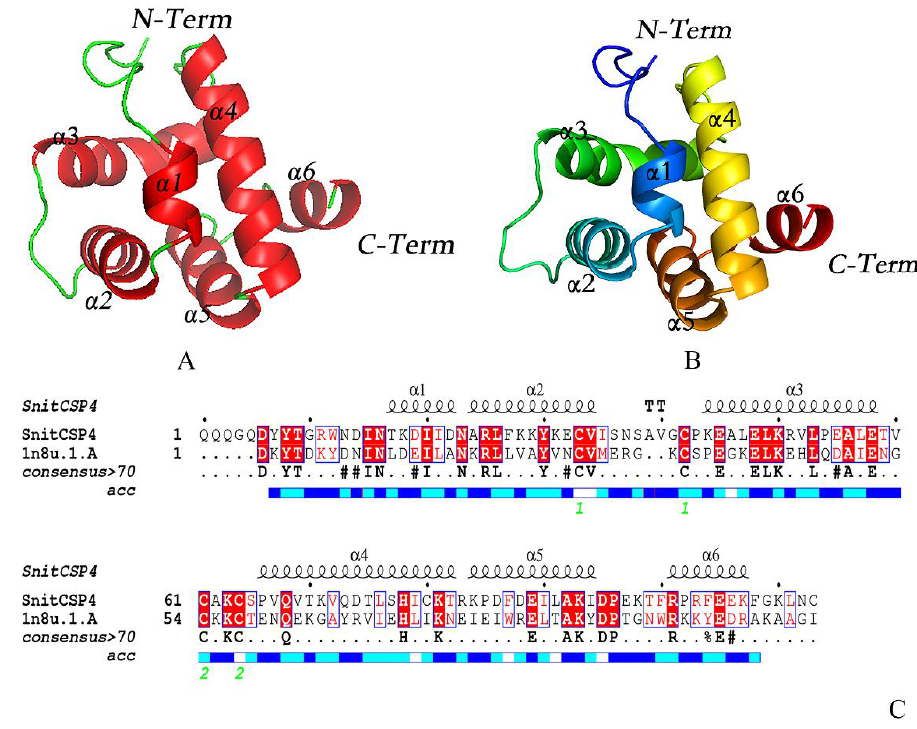
Figure 4. The 3D structure of SnitCSP4. (A) Structural modeling of SnitCSP4; (B) Corresponding modeling template of SnitCSP4; (C) Sequence comparison of SnitCSP4 with its modeling template. The six α - helices are marked as α1 - α6. C -term and N-Term are abbreviations for C-terminus and N-terminus, respectively.